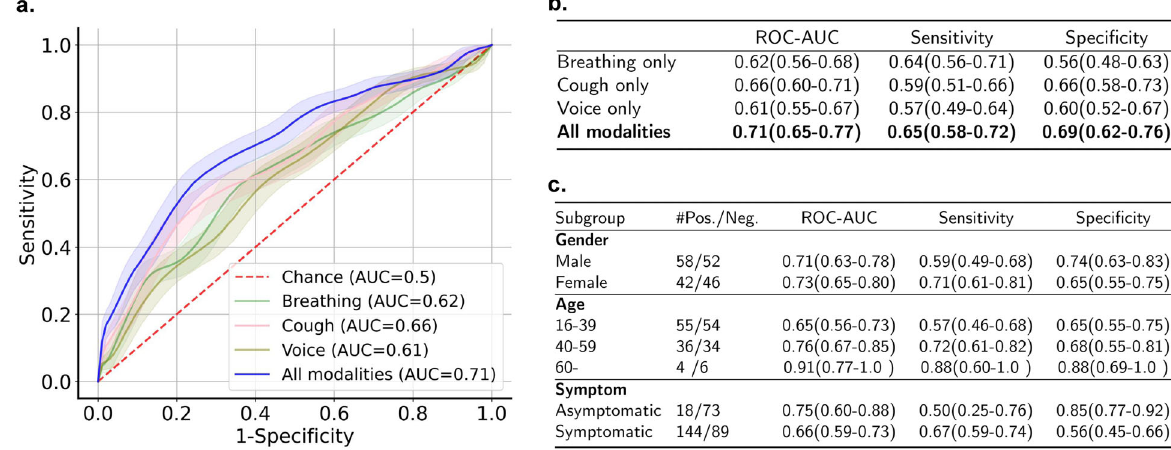
Fig. 2 Model performance. a Receiver-operating characteristic curve for the binary classi fi cation task of diagnosing COVID-19. b ROC-AUC, sensitivity and speci fi city with 95% con fi dence intervals in brackets for the combination of all modalities or each single modality separately. c Subgroup performance comparison under three modalities. For gender and age group, # denotes the number of unique positive/negative participants. Note that some participants provided multiple samples, which could be either asymptomatic or symptomatic.